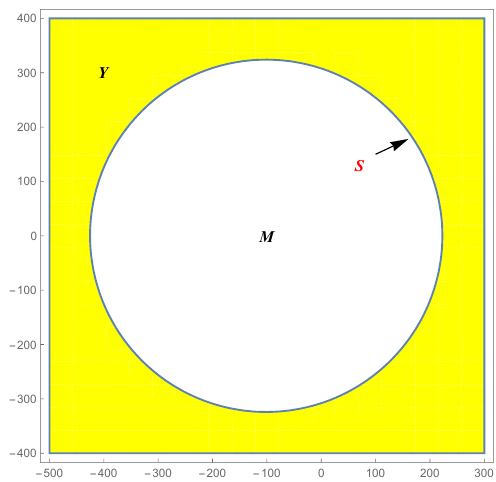
Figure 2. Stability circle S for strange fixed point z ( λ ) =